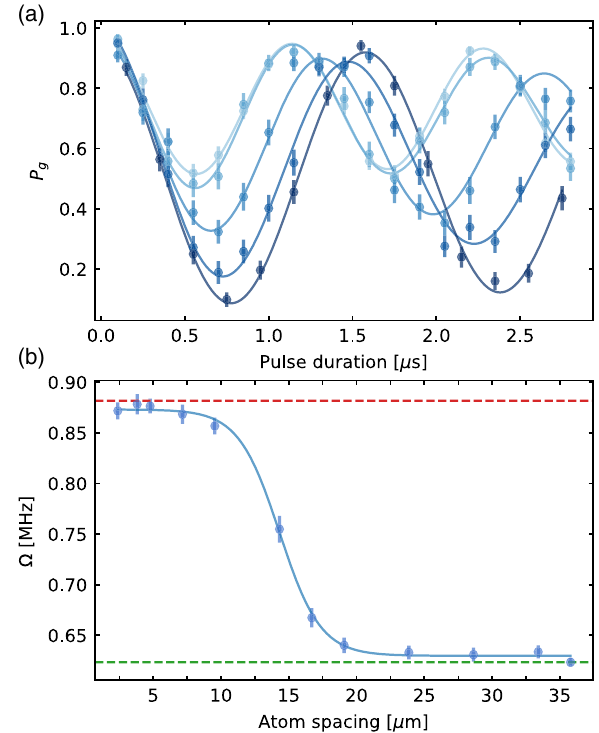
FIG. 7. Measuring the blockade radius. (a) We observe Rabi oscillations dimers with atom separations between 36 (dark blue) and 2 . 4 μ m (light blue). (b) The fitted oscillation frequency as a function of atomic spacing. The oscillation frequency increases 2 π × 0 . 63 MHz (green dashed line) to approximately from Ω ffiffiffi r ¼ p 2 Ω (red dashed line) in the blockade regime. The deviation from ffiffiffi r p 2 the exact ratio is attributed to a drift in the UV power over the duration of the measurement. The line is a phenomenological fit to extract the blockade radius R , where C 6 =R 6 ¼ Ω r . This occurs ffiffiffi b b p 2 Ω when the oscillation frequency is halfway between Ω and . r r In all panels, the error bars show (cid:3) 1 σ statistical